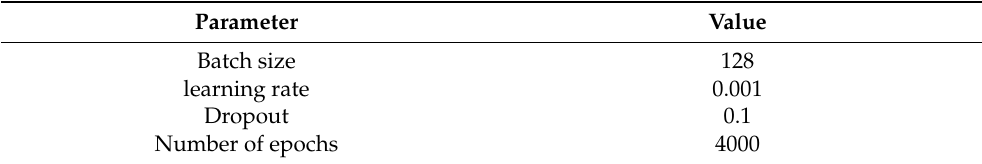
Table 1. List of parameter values used in Dilated CNN training.